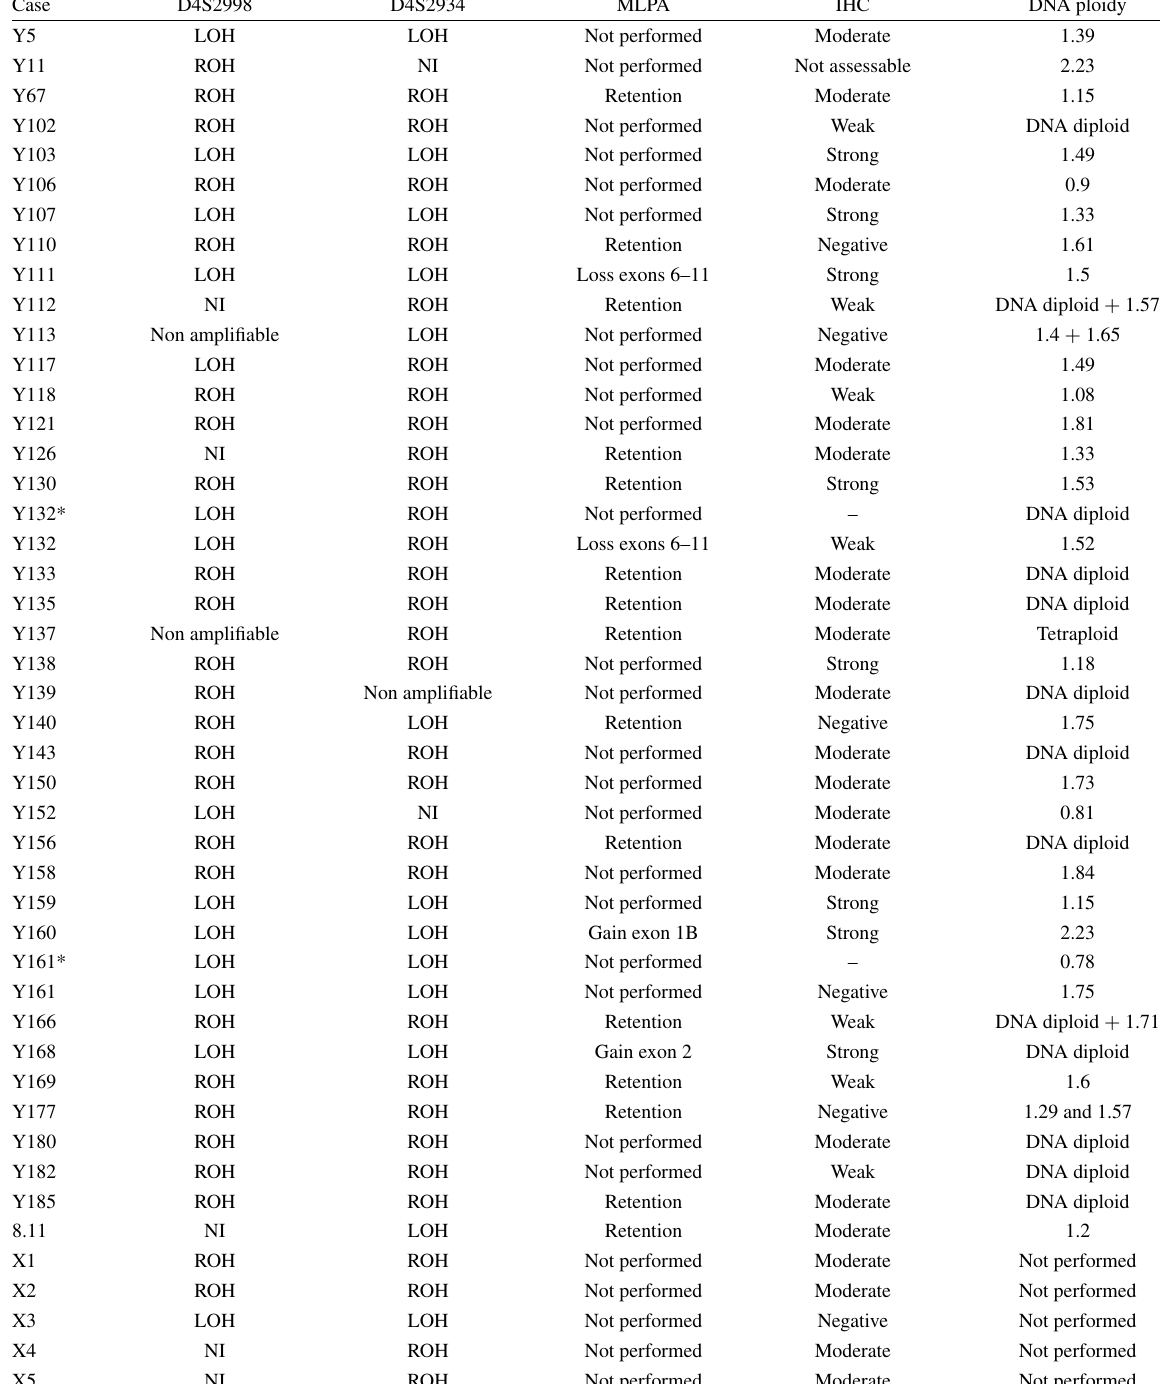
Results of LOH, MLPA and IHC on